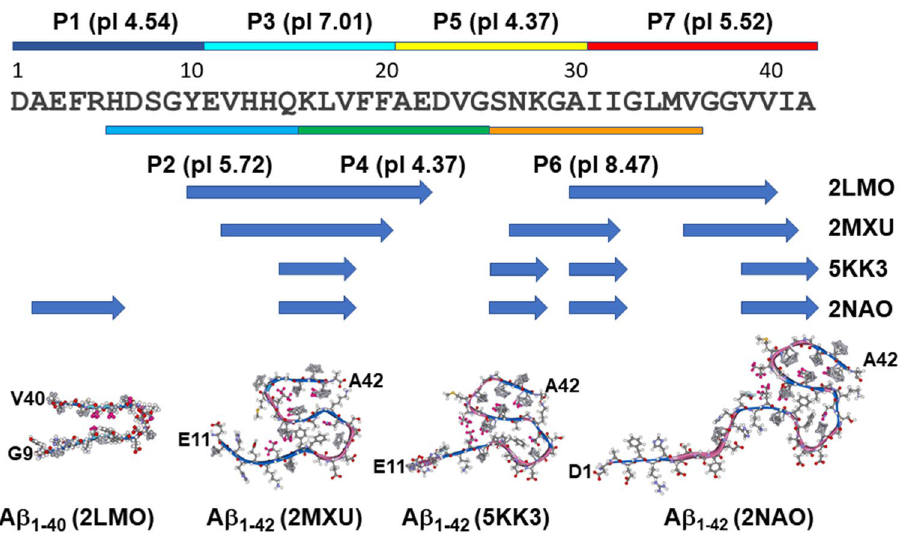
Figure 1. Aβ 1–42 amino acid sequence in single-letter format, with stretches corresponding to peptides P1 through P7 shown by horizontal bars of different colors above or below the sequence, along with respective theoretical isoelectric points (according to ExPASy ProtParam function, https:// web. expasy. org/ protp aram). Horizontal blue arrows below the sequence show the segments corresponding to β-sheet structures in Aβ 1–40 or Aβ 1–42 fibrils determined experimentally, with Protein Data Bank entries shown on the right-hand side. Segments left blank are described as loop or turn regions. In the lower panel, one structure for Aβ 1–40 and three structures for Aβ 1–42 in fibrillar form are shown (fibril axis and the direction of interstrand H-bonding are perpendicular to the plane of the image). Backbone regions in β-sheet and turn/loop conformations are colored blue and rose,